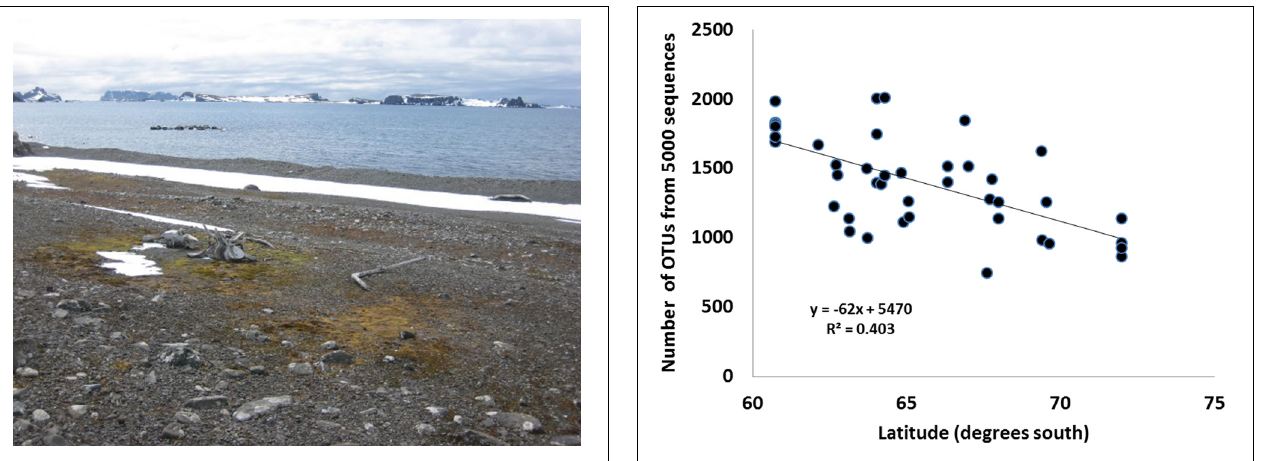
FIGURE 11 | Relationship between the number of operational taxonomic units (OTU) for 5000 16S rRNA gene sequences and latitude for soil samples from the maritime